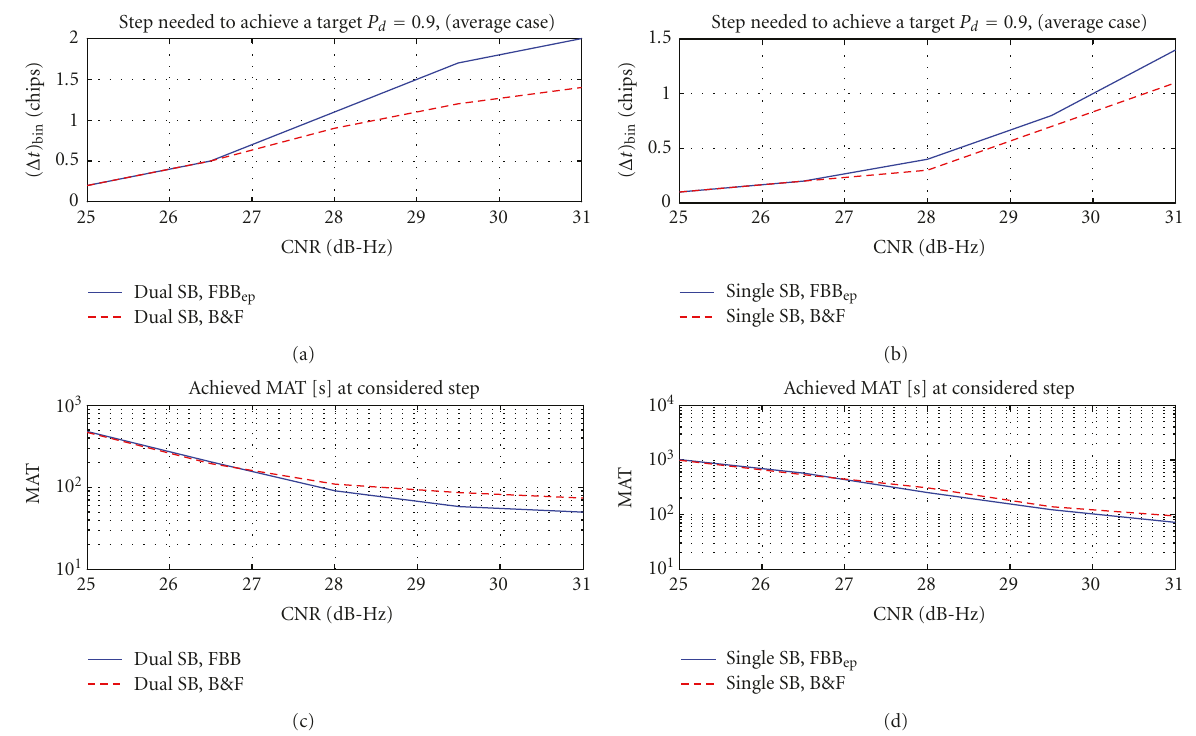
Figure 9: Step needed to achieve a target average P d = 0 . 9, at false alarm P fa = 10 − 3 and corresponding mean acquisition time, SinBOC(1,1) signal. Code length 4092 chips, penalty factor K penalty = 1, single frequency-bin. N pieces = 2 for FBB ep . Left: dual sideband. Right: single